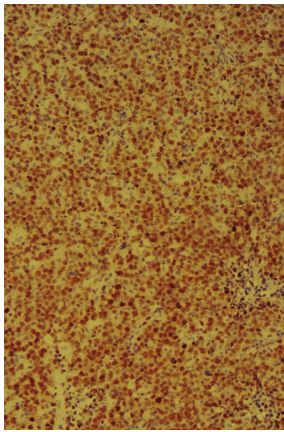
Figure 5: Lymph node biopsy immunohistochemical staining showing MUM1 expression.